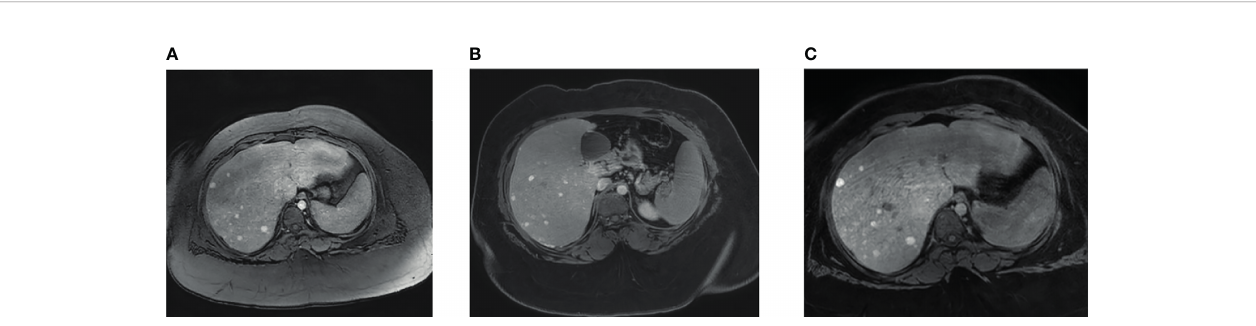
FIGURE 1 | MRI liver fi ndings. (A) Contrast enhanced liver MRI image showing multiple small liver lesions showing early arterial enhancement. (B) Lesions showing retention of contrast after 6 minute delay. (C) Lesions showing retention of contrast after 31 minute